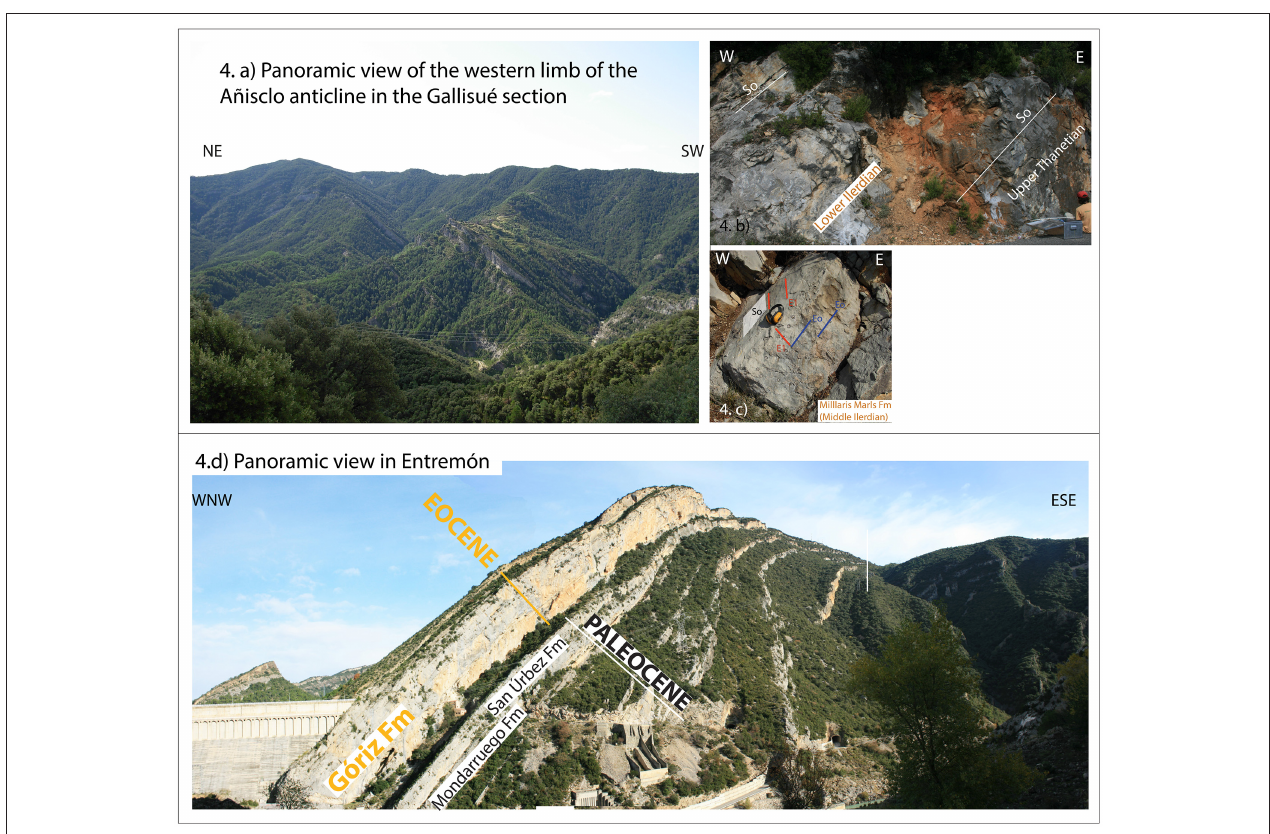
FIGURE 4 | (a) Panoramic view of the Eocene western limb of the Añisclo anticline, (b) the transition of the Paleocene to the Eocene (Thanetian-Ilerdian) masked by karstification, (c) a sampled site with two pressure solution family planes (E 0 : pressure solution planes parallel to bedding planes; E 1 : pressure solution planes related to the alpine deformation, tilt to the east in this outcrop), and (d) Photograph of the western limb of the Mediano anticline showing the sampled rocks of the Entremón section. The dam of the Mediano reservoir appears on the